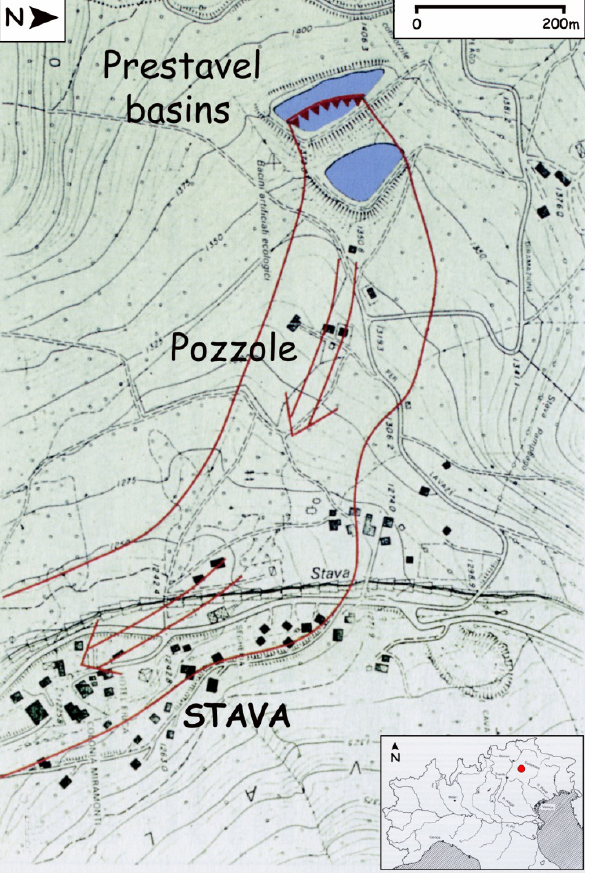
Fig. 3 – 1981 ‐ 82: bottom view of the two basins almost completely replanted. It is possible to notice the progressive levels of growth achieved by hydrocyclone and the caretaker's house in the foreground (courtesy of Fondazione Stava 1985).